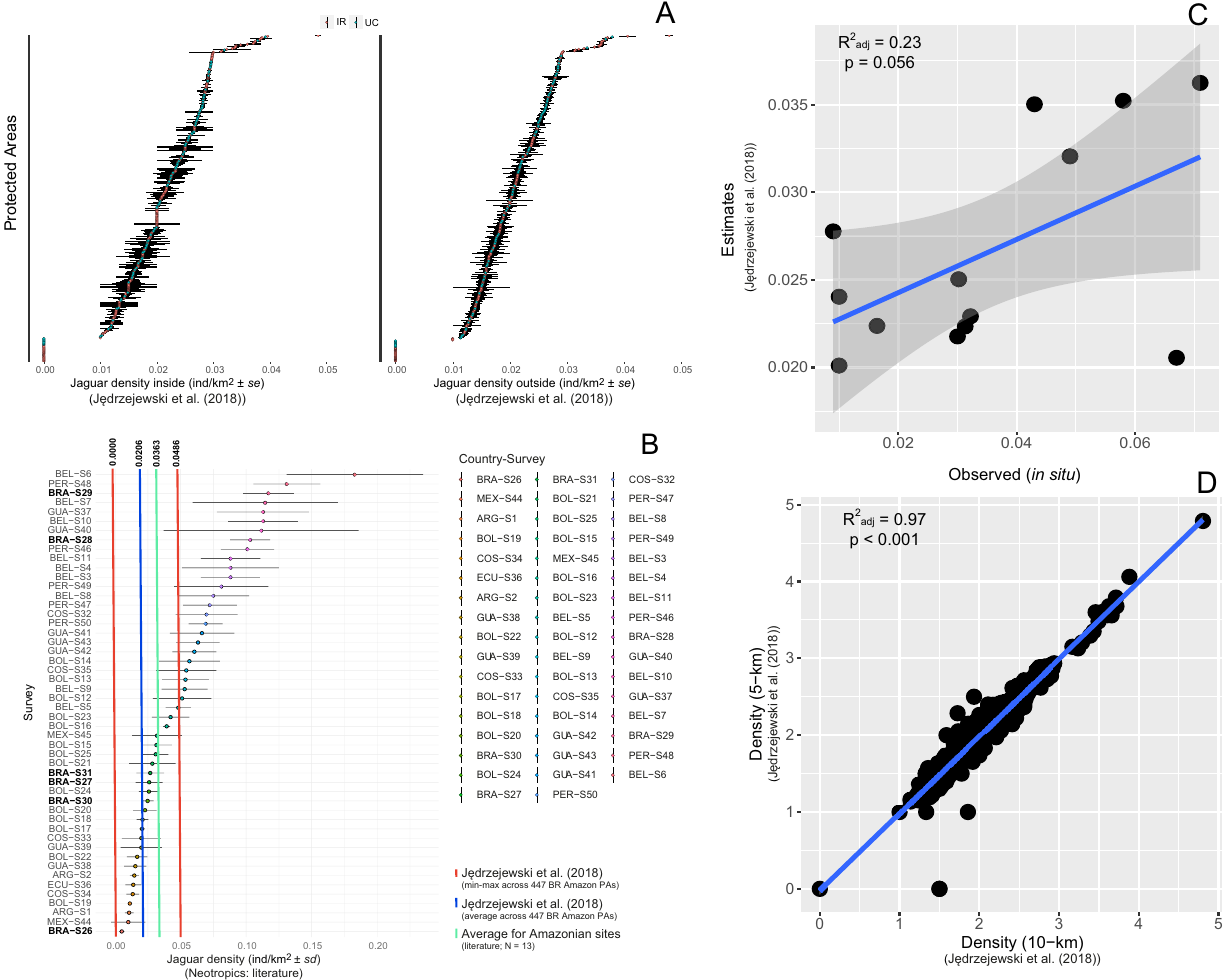
Fig. 1 Jaguar density bias and buffer size evaluation. A Jaguar density estimates (derived from ref. 25 ) and standard errors (SE) for 447 protected areas across Brazilian Amazon. B Summary of fi eld surveys deriving in situ jaguar density estimates and the main trends derived from our bias evaluation of the J ę drzejewski et al. 25 estimates; C Jaguar density in situ vs. J ę drzejewski et al. 25 estimates for sites across the Brazilian Amazon (including country-border sites); and D Jaguar density estimates within 5 and 10 km buffer areas around PAs across the Brazilian